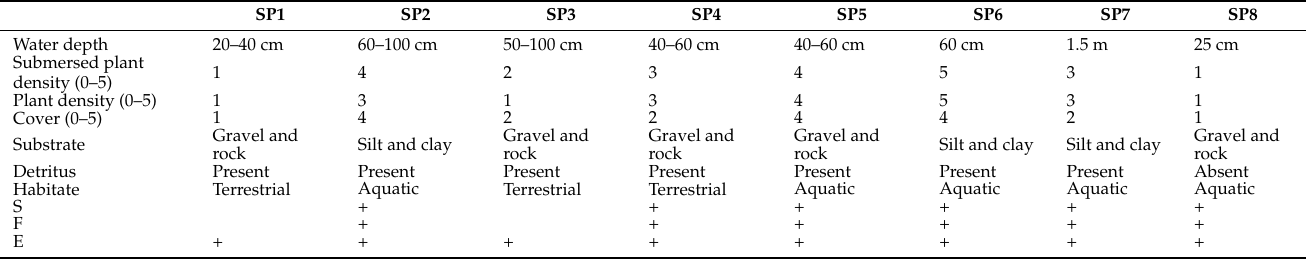
Table 6. The species density in each sampling point based on Kohler’s 5-point